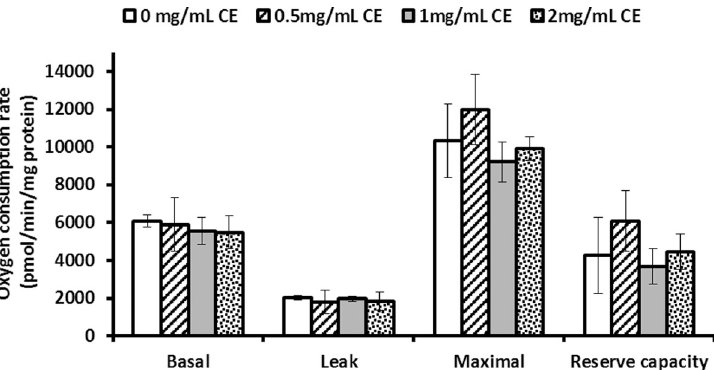
Fig 3. Basal, leak and maximal oxygen consumption rates and reserve capacity in Caco-2 monolayer exposed to A . simplex CE. Caco-2 cells were cultured using DMEM-galactose for 15 days. Differentiated cells were then incubated with A. simplex CE (0.5, 1 and 2 mg/mL) for 2 hours and basal, leak, maximal oxygen consumption rates and reserve capacity were determined. The results are expressed as mean ± SD. No significant differences were found in basal (P = 0.636), leak (P = 0.690) and maximal (P = 0.097) OCR and reserve capacity (P = 0.124).